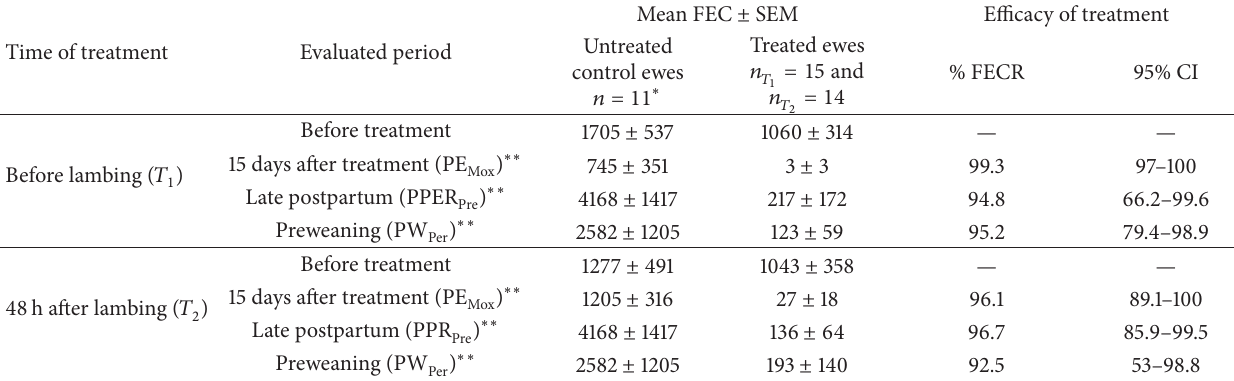
Table 1: FECR induced by moxidectin strategic treatment of periparturient ewes during the same reproductive cycle.